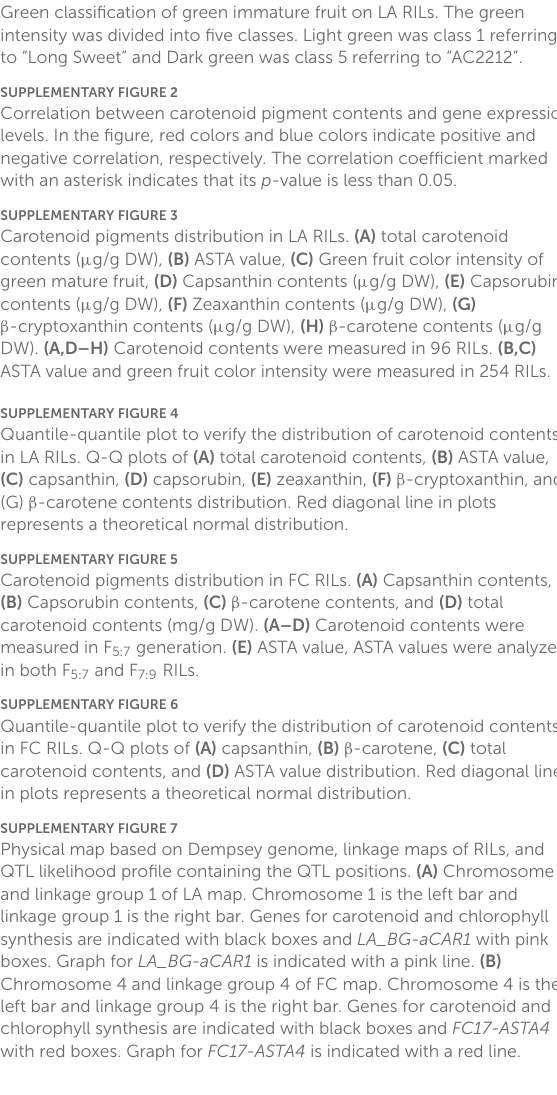
SUPPLEMENTARYFIGURE1 Green classification of green immature fruit on LA RILs. The green intensity was divided into five classes. Light green was class 1 referring to “Long Sweet” and Dark green was class 5 referring to